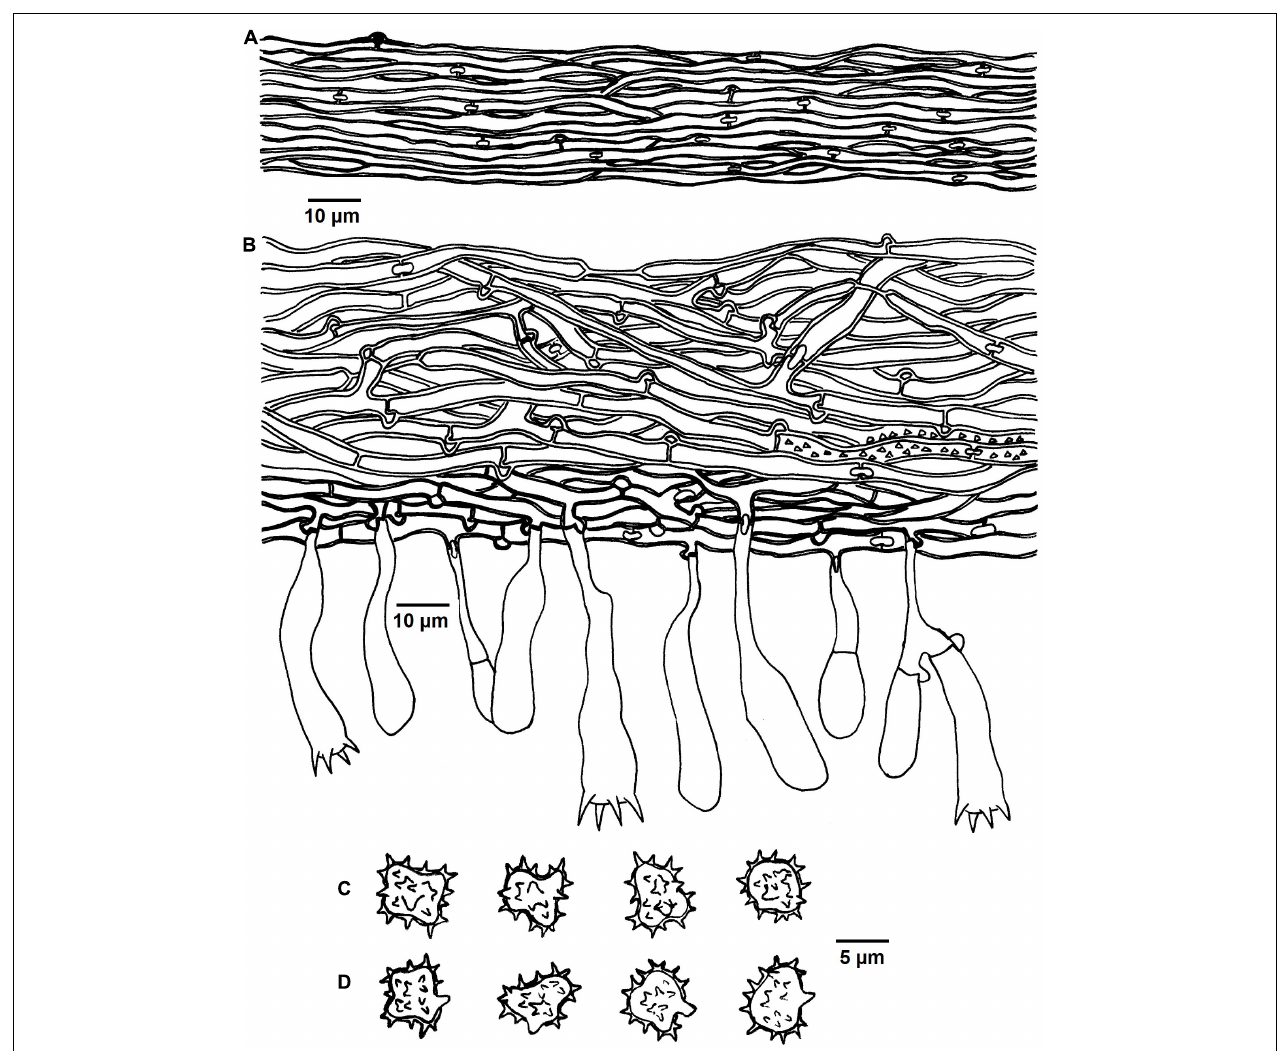
FIGURE 8 | Microscopic structures of Tomentella stipitobasidia (drawn from Yuan 12713). (A) Hyphae from a rhizomorph. (B) A section through basidiocarp. (C) Basidiospores in lateral view. (D) Basidiospores in frontal